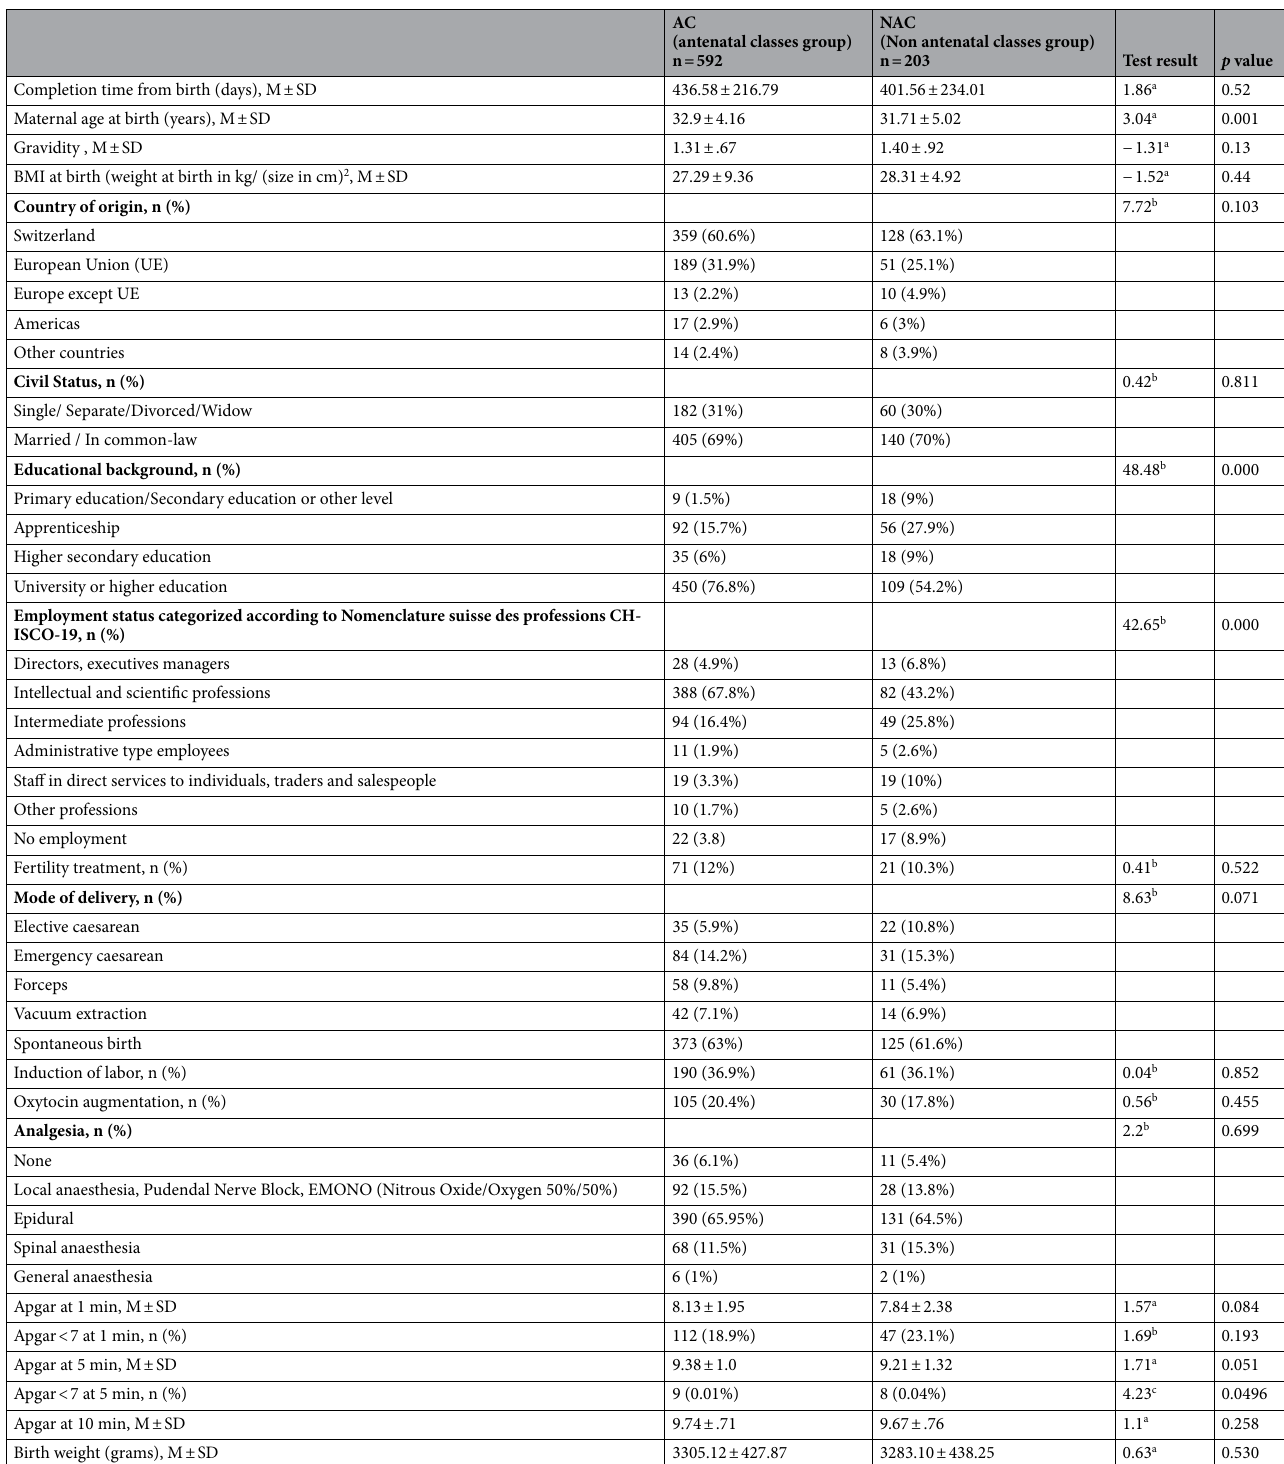
Table 1. Sociodemographic sample characteristics and obstetric and neonatal outcomes (n = 795). a Independent sample t test. b Chi2 test. c Fischer exact